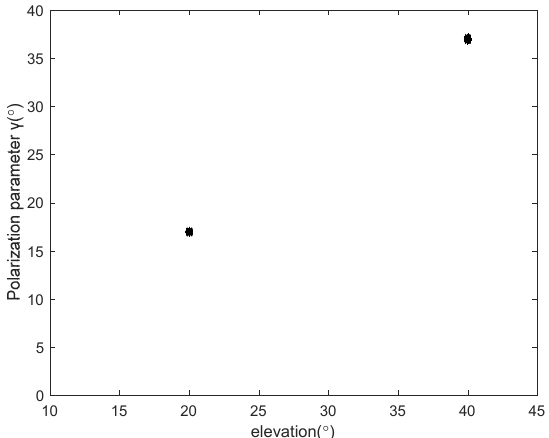
Figure 7. Scatter plot of θ and γ .